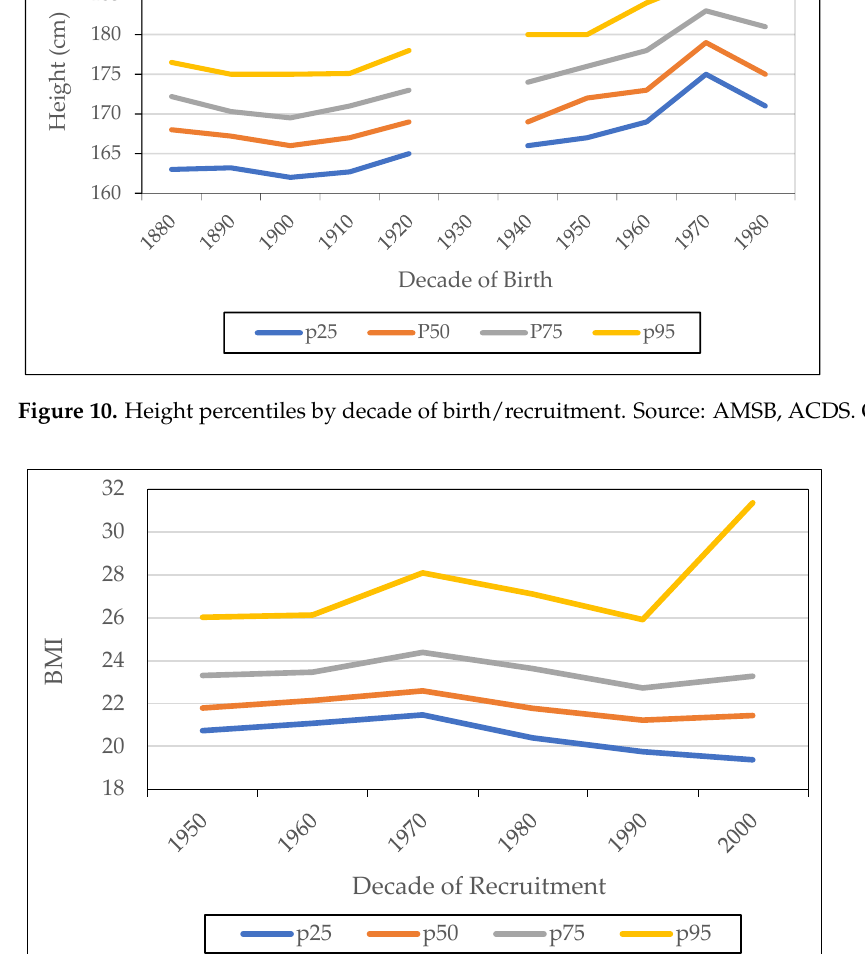
Table 5. Summary statistics by social class group (full sample).